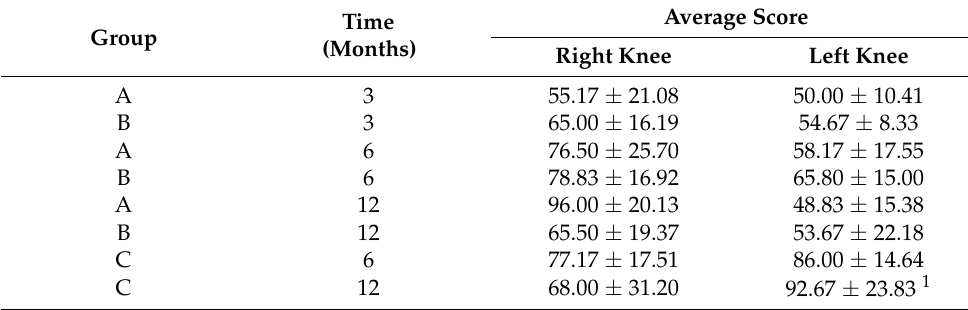
Table 4. Histopathological results of femur.